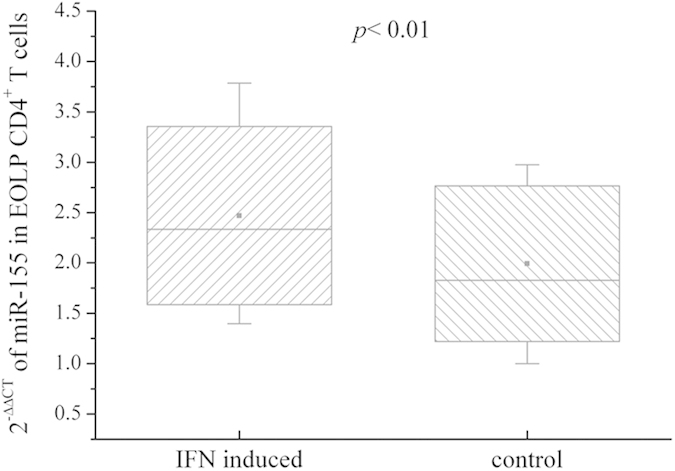
The expression of miR-155 in EOLP CD4+ T cells induced with IFN-γ.The significant differences between IFN-γ induced group and the blank controls were tested by independent-samples t test, and results are represented as box plots.